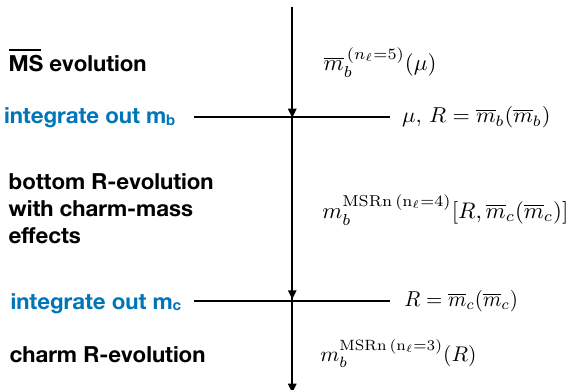
Figure 4. Graphical representation of the sequence of R-running and matching that one needs to carry out to evaluate the MSR ( n ‘ ) and MSR ( n ‘ (cid:0) 1)